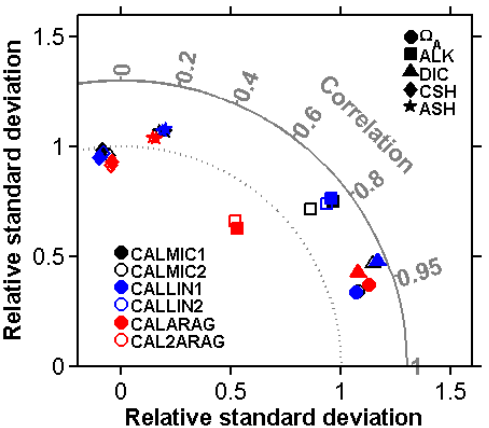
Fig. 9. Taylor diagram comparing modeled global fields of arag- onite saturation state, alkalinity, and DIC for different parameter- izations of the CaCO 3 production to observation-based estimates (GLODAP; Key et al., 2004). The modeled and estimated satura- tion horizons with respect to calcite (CSH) and aragonite (ASH) are